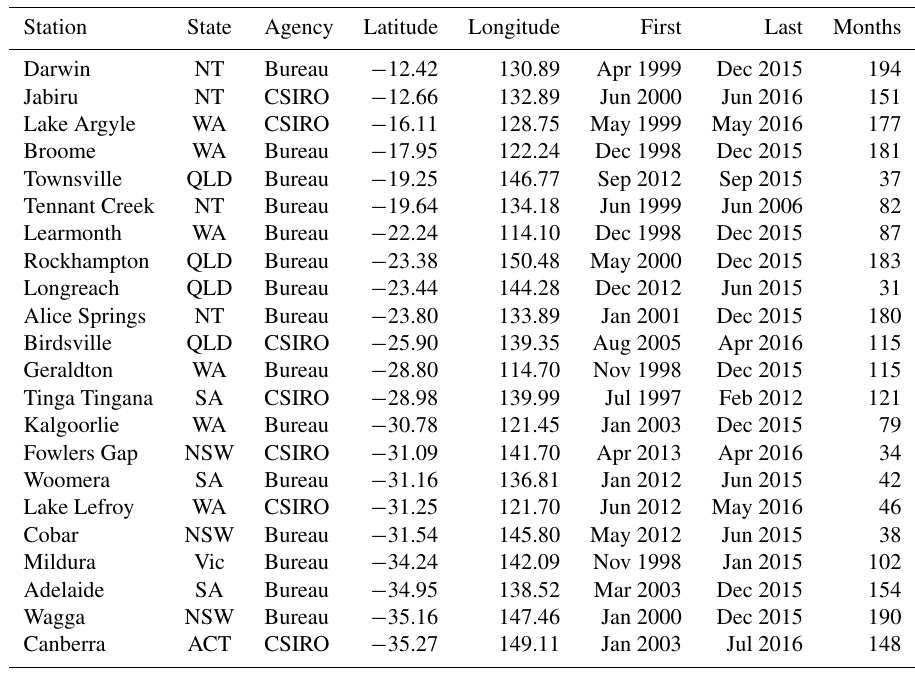
Table 1. Details of the 22 stations considered in this study.